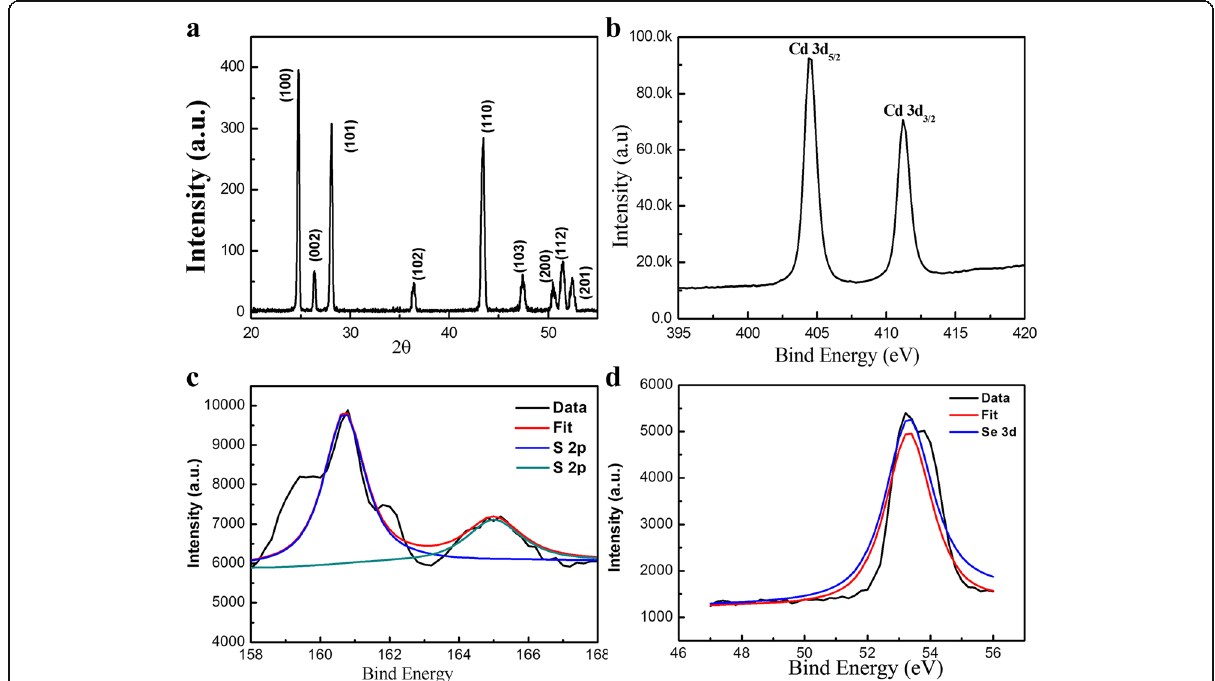
Fig. 4 XRD patterns and XPS spectra of the CdSSe NBs. a XRD. b XPS spectrum of superposed Cd(3d). c High-resolution XPS spectrum for S(2p). d High-resolution XPS spectrum for